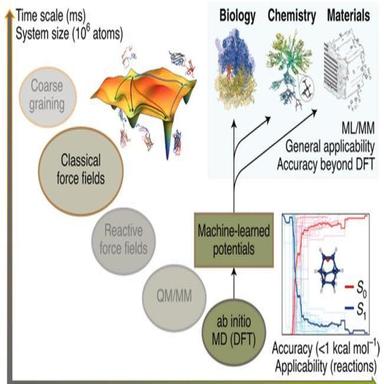
.1. Interplay between system scale and simulation precision for different methodologies. While ReaxFF and other approaches provide access to length and time scales inaccessible to DFT-based simulations, their accuracy and degree of applicability gradually diminishes. In contrast, MLIPs can maintain high accuracies while simulations increase in time and system size.